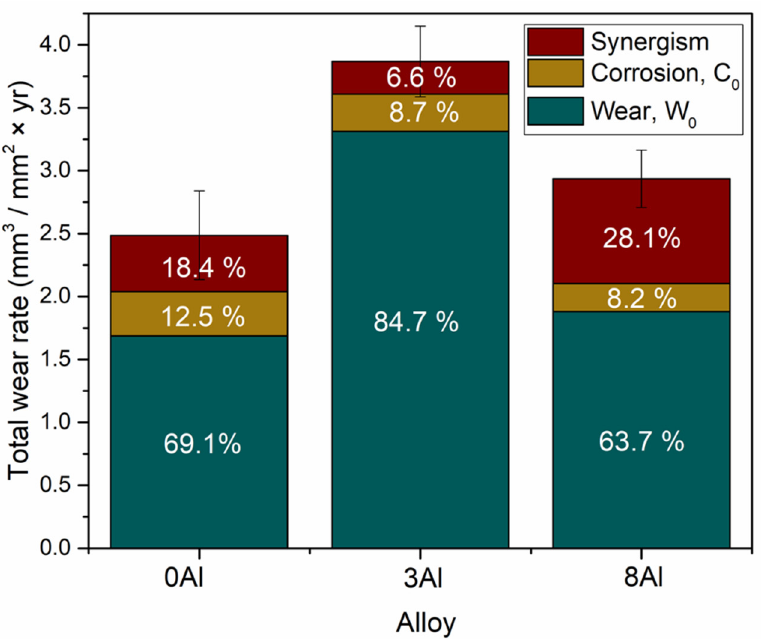
Figure 10. Total wear rates and contribution of pure sliding wear, corrosion, and the synergistic effect.